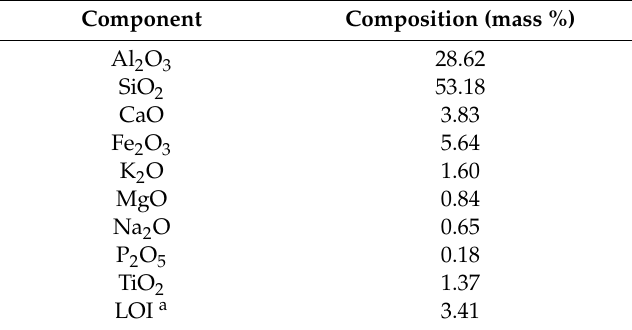
Table 1. Oxide composition of the fly ash.